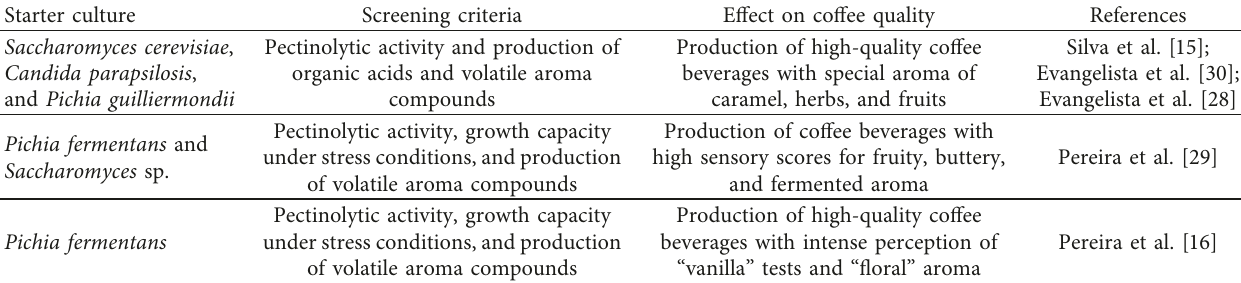
Table 3: The list of developed culture and their characteristics and effect on coffee fermentation. Starter culture